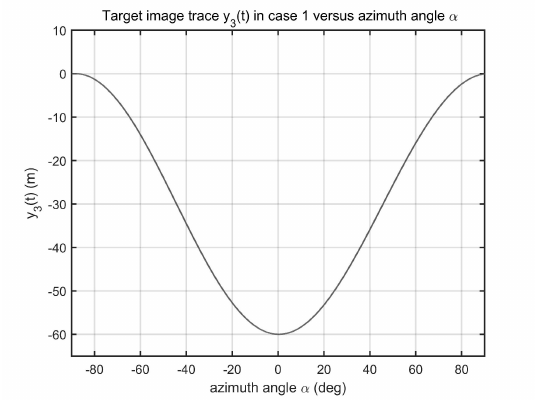
Figure 8. Calculated target image trace y 2 ( t ) in case 1 versus azimuth viewing angle α .